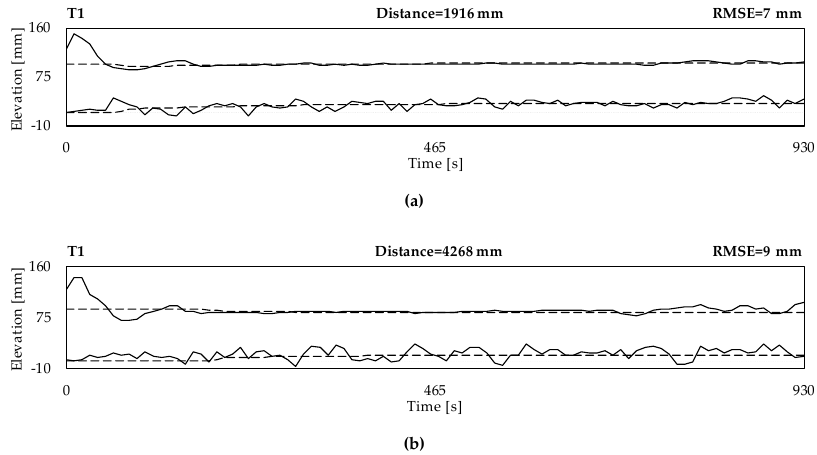
Figure 3. Temporal evolution of bed and water profiles for the experiment T1 obtained experimentally (continuous) and numerically (dashed) at about (a) 1.9 m and (b) 4.3 m from the channel inlet. The time instant 0 s corresponds to the beginning of the sediment release. The vertical coordinates were measured with respect to the initial bed surface elevation at the channel outlet. The initial bed level is indicated by the gray line.